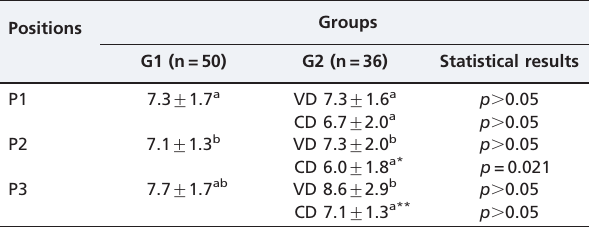
Table 5 - Length of PFM contractions (cmH 2 O) (seconds) (mean and standard deviation) in the nulliparous group compared to the primiparous 45 days postpartum group according to the type of delivery, measured using a perineometer in different positions: supine with the lower limbs straight (P1), supine with the lower limbs bent (P2), and sitting (P3). Different lower-case letters indicate significant differences between the groups at the same time point.